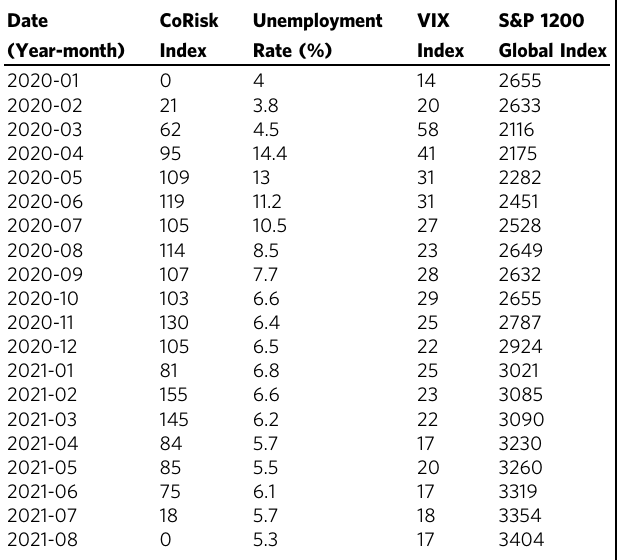
Table 1 Aggregated monthly data used in Granger causality